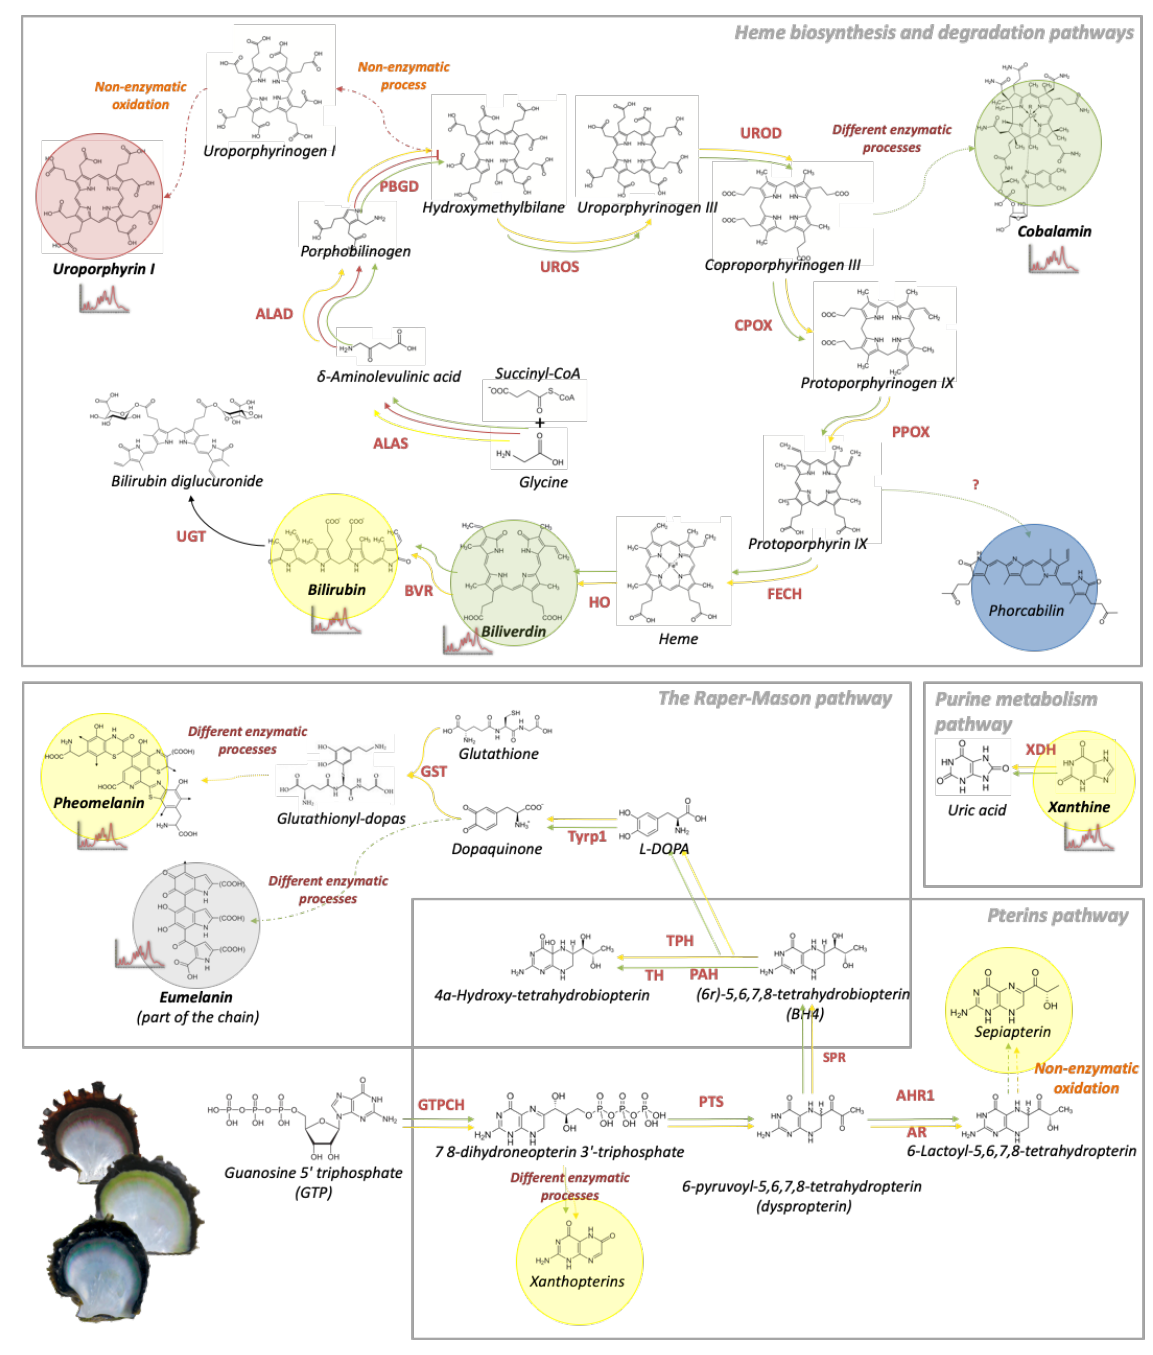
Figure 7. The four identified pathways responsible for P. margaritifera inner shell color: the heme biosynthesis and degradation pathways, the pterins pathway, the Raper–Mason pathway, and the purine metabolism pathway. The putative pigments are shown with colored circles; those validated by Raman spectroscopy have a Raman graph symbol. The red, yellow, and green arrows refer to the synthesis of red, yellow, and green pigments, respectively. ALAS: aminolevulinic acid synthase; ALAD: delta-aminolevulinic acid dehydratase; PBGD: porphibilinogen deaminase; UROS: uroporphyrinogen III synthase; UROD: uroporphyrinogen decarboxylase; CPOX: coproporphyrinogen oxidase; PPOX: protopor- phyrinogen oxidase;